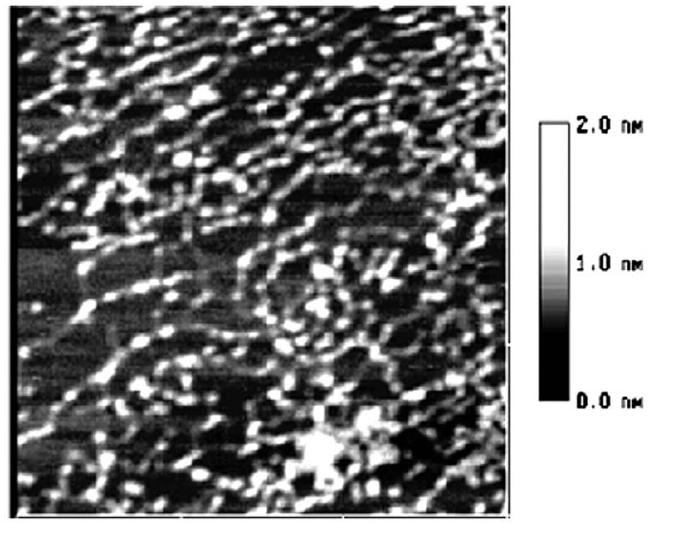
Figure 4. The AFM image of starch nanochains when heated in 100 °C water bath for 15 min, size 600 × 600